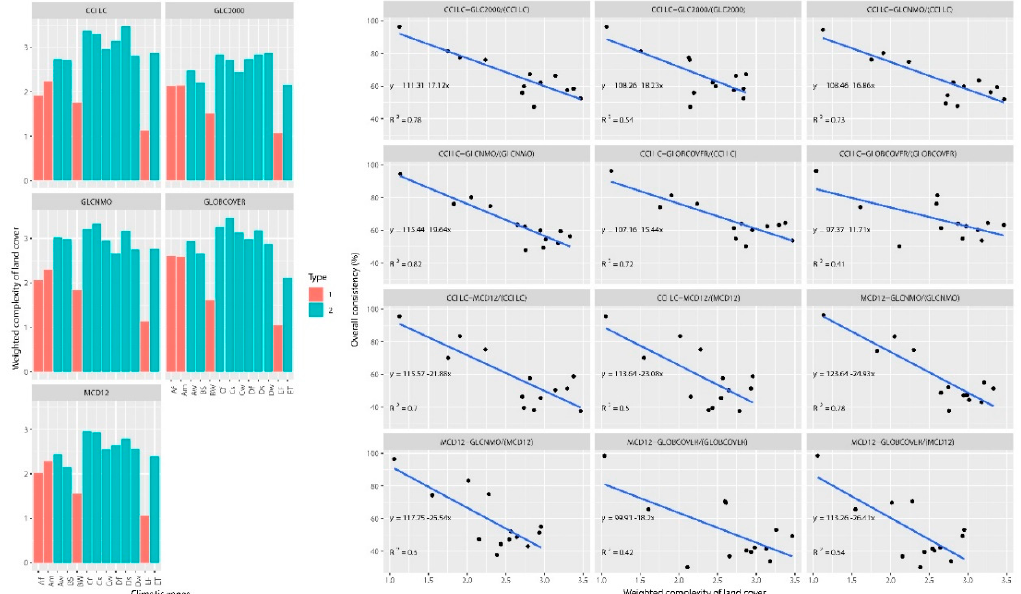
Figure 6. The relationship between the weighted complexity of land cover from surface conditions and spatial consistency. The left is the weighted complexity of the land cover in each climatic zone, with the red color indicating a higher overall consistency of the climatic zone and different letters represent different climatic zones including 13 areas: Af for equatorial rainforest and full humid, Am for equatorial monsoon, Aw for equatorial savannah, BW for desert climate, BS for steppe climate, Cs for warm temperate climate with dry summer, Cw for warm temperate climate with dry winter, Cf for warm temperate climate and fully humid, Ds for snow climate with dry summer, Dw for snow climate with dry winter, Df for snow climate and fully humid , ET for tundra climate, and EF for frost climate. The right has regression equations between the overall consistency and weighted complexity of the land cover for different climatic zones. The first two datasets before “/” are for the overall consistency analysis, and the dataset in “()” is for calculating the weighted complexity of the land cover.